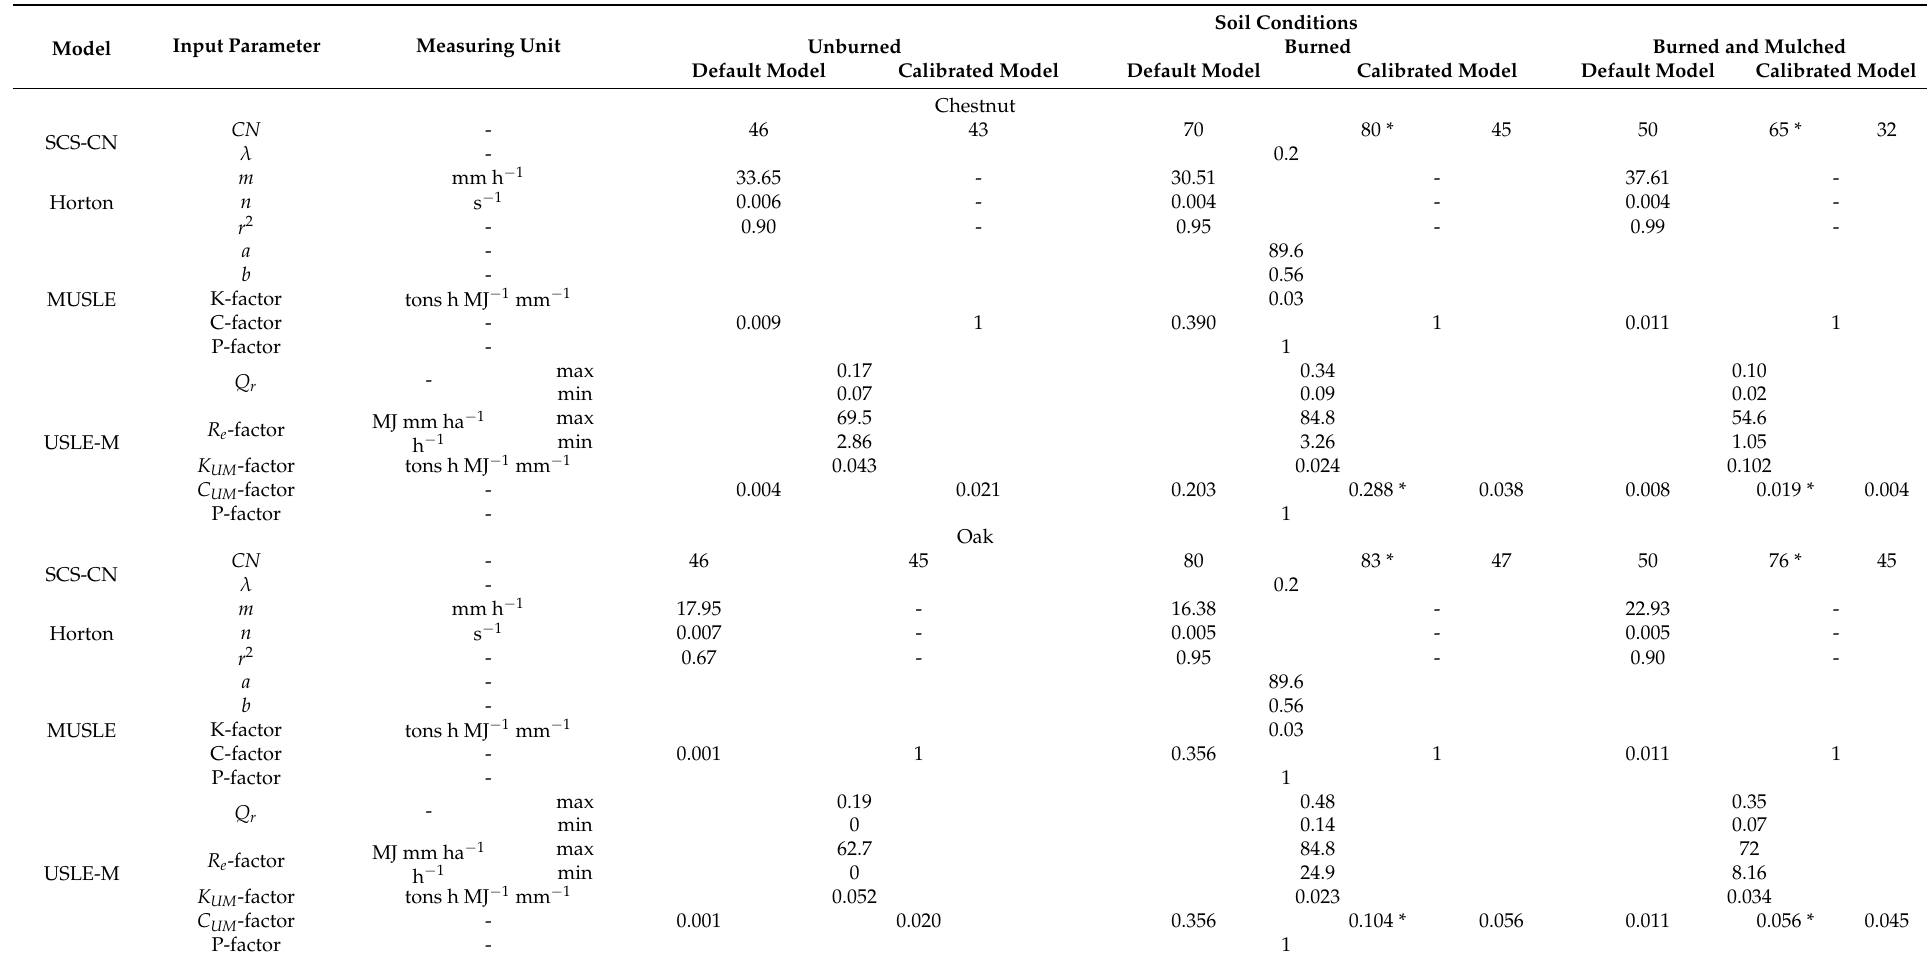
Table 2. Values of input parameters adopted to simulate surface runoff volumes and soil loss using the SCS, Horton, MUSLE, and USLE-M models applied in the experimental plots.